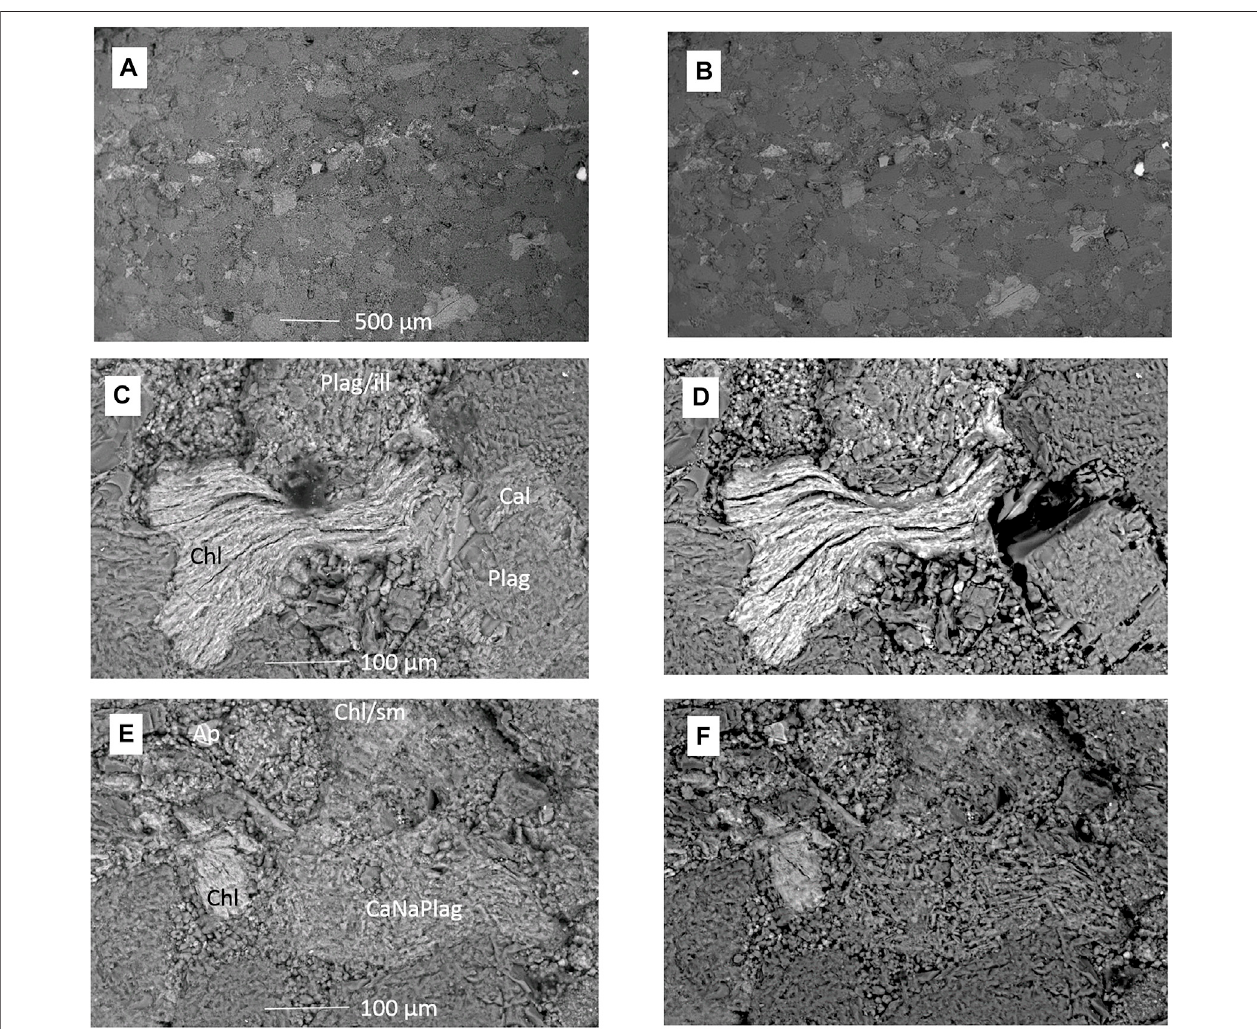
FIGURE 5 | SEM images of the feldspar-rich sandstone 1043.70 m core block surface before and after CO 2 -formation water reaction. (A) Area showing a vein before reaction and (B) after reaction. (C) Chlorite, plagioclase, and calcite cement before reaction and (D) after reaction with calcite dissolved and chlorite altered. (E) Framework grains and clays before reaction and (F) after reaction with the Ca-Na-plagioclase (CaNaPlag) corroded. Plag, plagioclase; Cal, calcite; Chl, chlorite; Plag/ill, plagioclase and illite mix; Ap, apatite; Chl/sm, chlorite and smectite mixture.